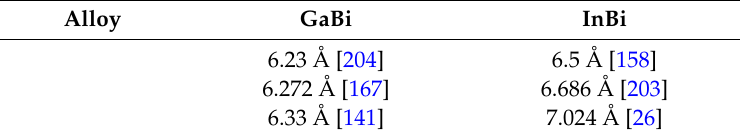
Table 6. Lattice constant for GaBi and